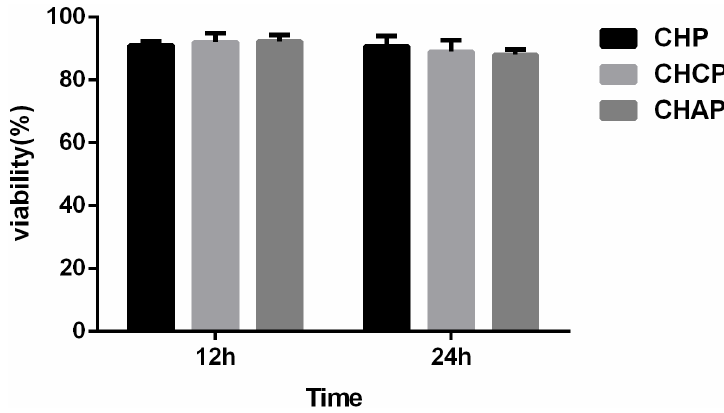
Figure 7. In vitro viability of HeLa cells with NPs at 12 and 24 h. Data are mean ± SD ( n = 3). Nanomaterials 2016 , 6 , 165